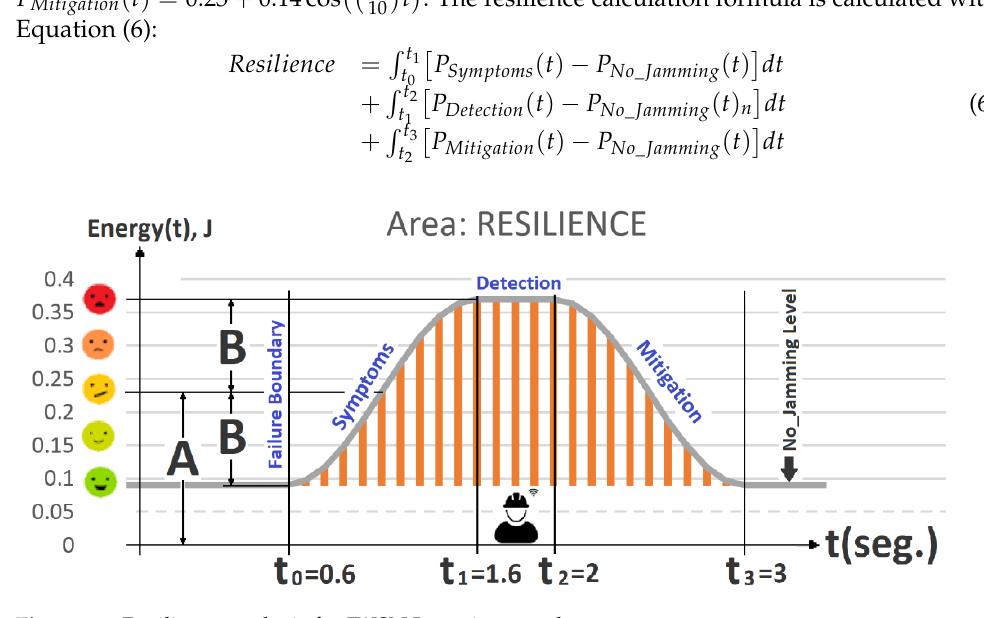
Figure 19. Resilience analysis for IWSN Jamming attack.